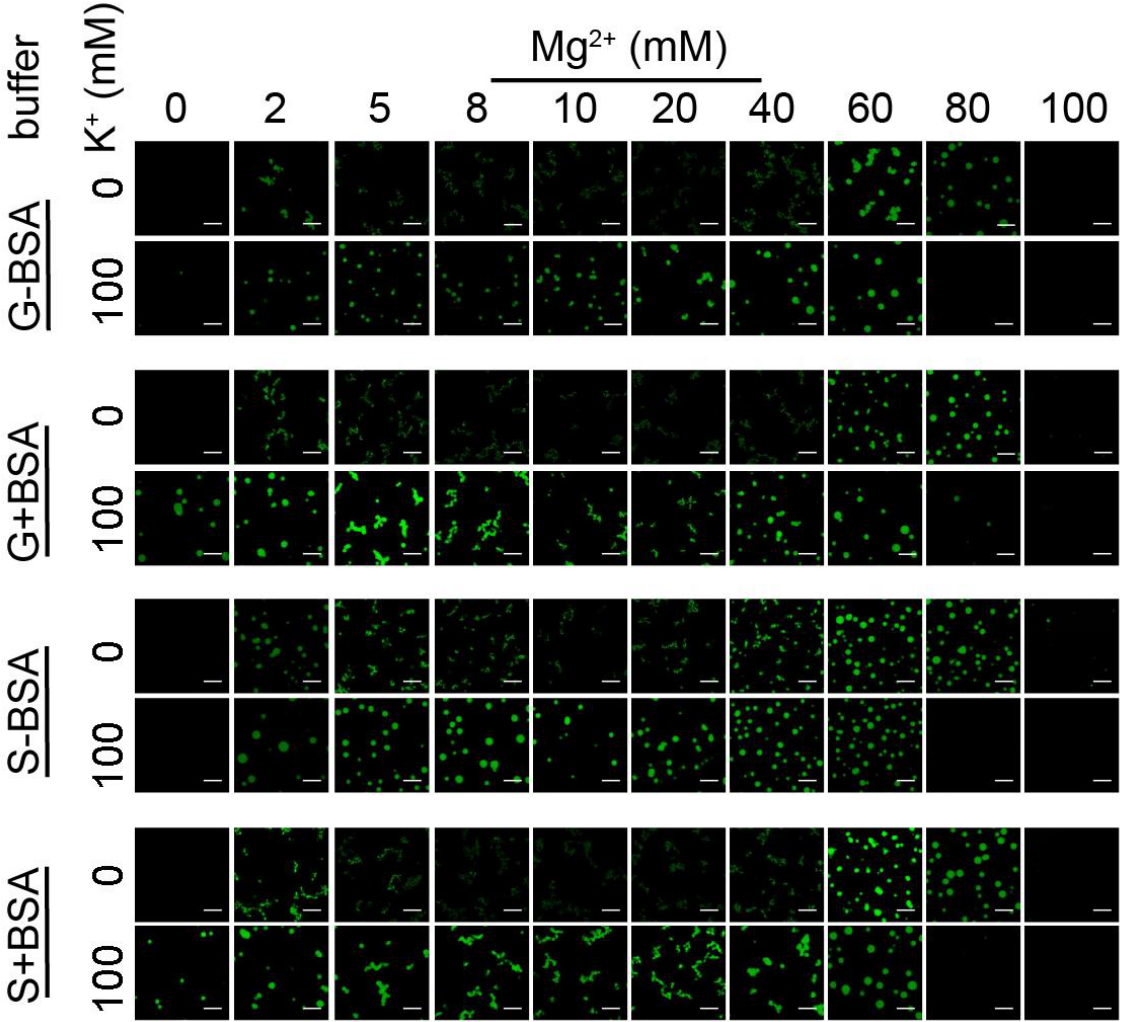
Figure 2. Reconstituted nucleosome arrays undergo LLPS in different buffer conditions. Confocal fluorescence microscopy images of 15-197-601 nucleosome arrays with DNA stained by DyeCycle in the absence and presence of 100 mM K + at four buffer conditions as a function of Mg 2+ concentration. The nucleosome array concentration is 375 nM. The detailed buffer components are listed in Table S1. Images for samples in conditions with wider range of Mg 2+ concentrations are shown in Figure S8. Scale bar represents 10 μ m.